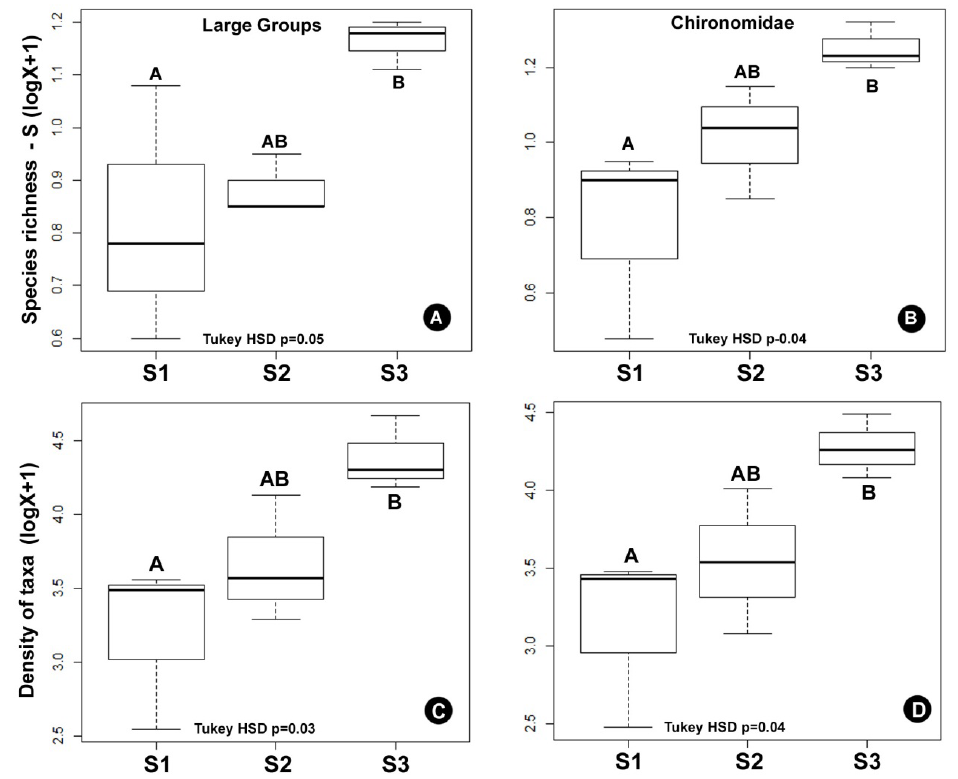
Figure 3. Boxplots in a logarithmic scale indicating significant differences among means comparing the richness and abundance of taxa of large groups (A, C) and chironomid genera (B, D) between sampling sites.